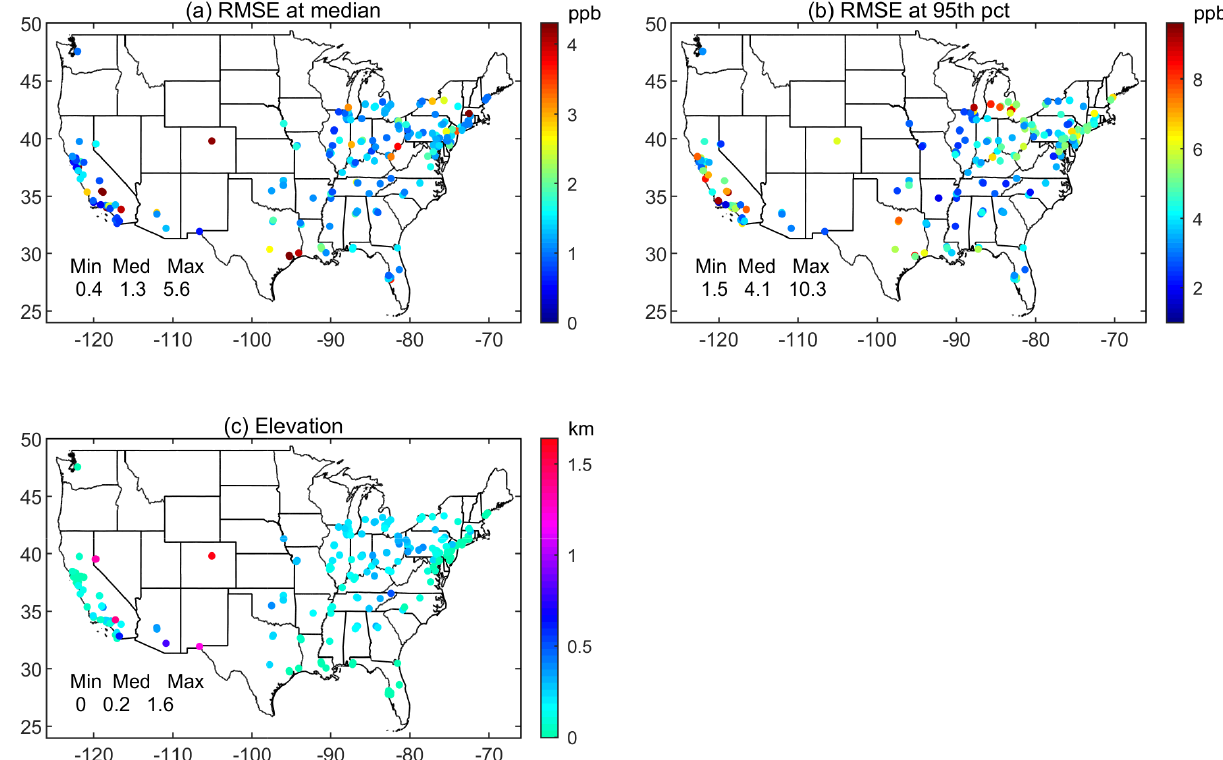
Figure 5. Spatial distribution of the lower bound for the RMSE or expected RMSE at each monitoring site over CONUS (a) at the median and (b) at the 95th percentile. (c) Elevation (km) above the mean sea level of each monitoring site.